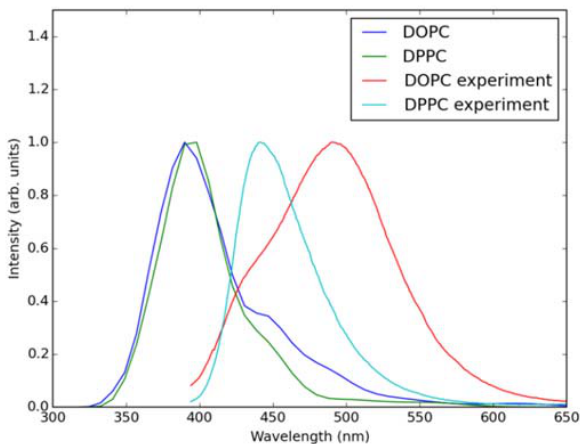
Figure 7. Histogram of tilt angle of Laurdan fluorophore in the S 1 state incorporated into lipid bilayers.